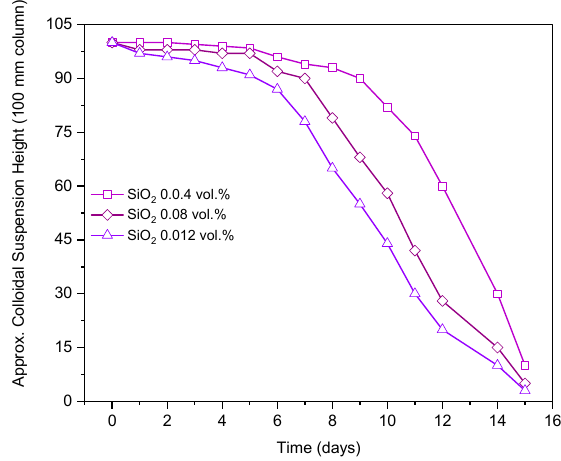
Figure 13. Colloidal suspension height in a column over time.